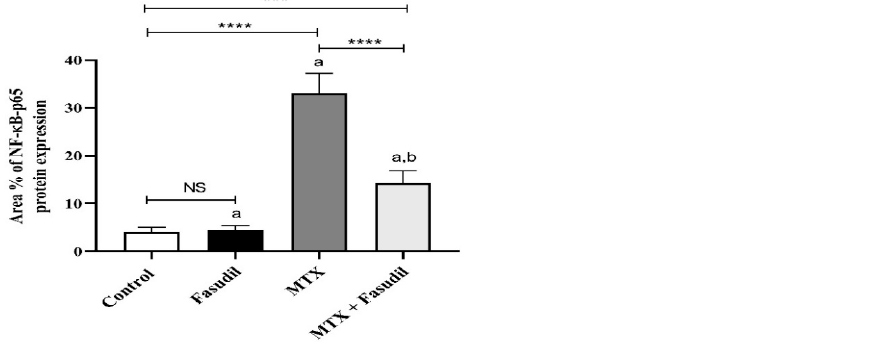
Figure 6. Effect of fasudil on NF- κ B-p65 immunostaining protein expression after MTX-challenge (IHC ×400). Arrows indicate the localization and expression of NF- κ B-p65 in hepatic sections. Scale bar = 200 µ m. The bar graph represents the quantitative determination of NF- κ B-p65 protein expression in different groups ( n = 6); a: significant difference from the control group ( p < 0.05); b: significant difference from the MTX group ( p < 0.05). *** p < 0.001. **** p < 0.0001. NS, non-significant.